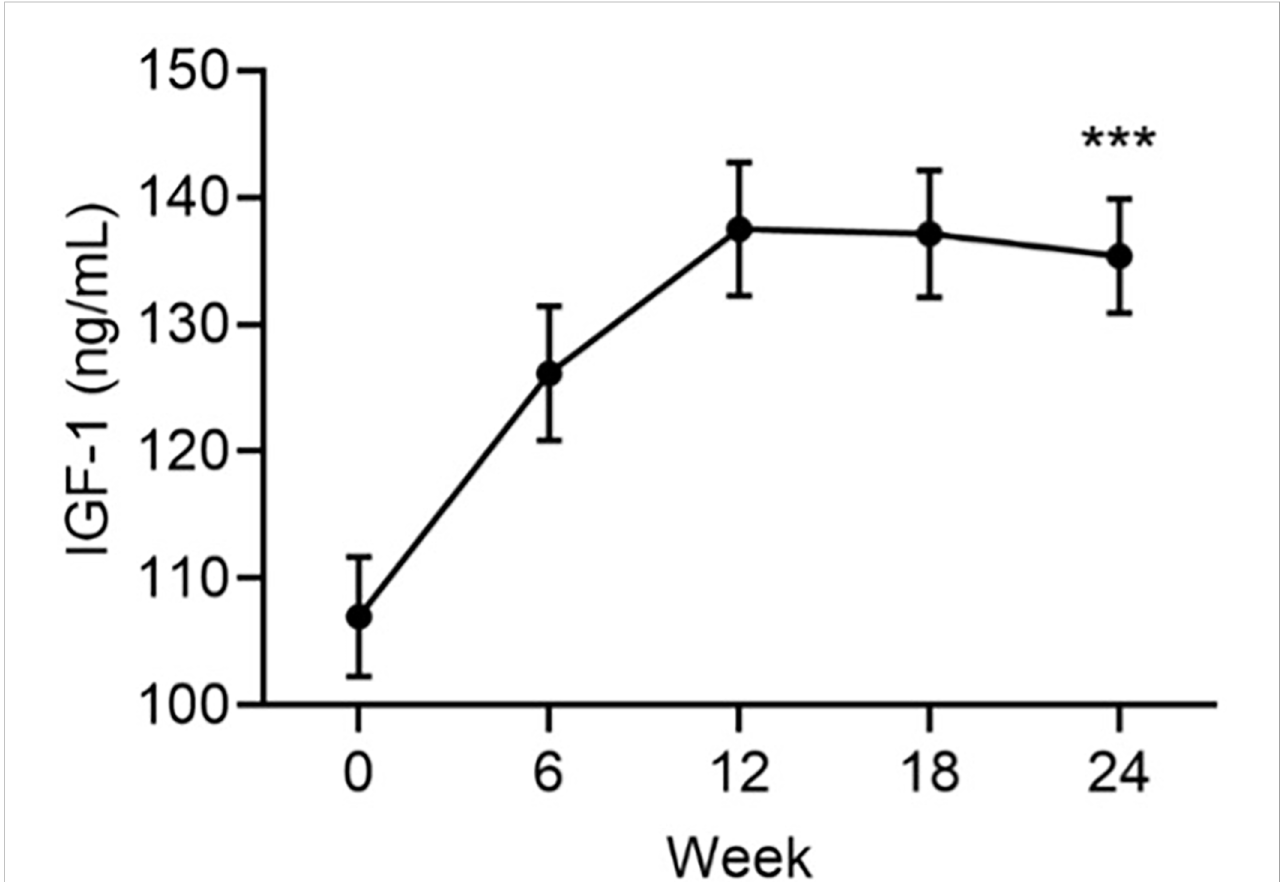
FIGURE 1 Mean serum levels of IGF-1 by visit. Data are mean ± SE by visit for all participants (N=84). ***p<0.001 for baseline vs endpoint.